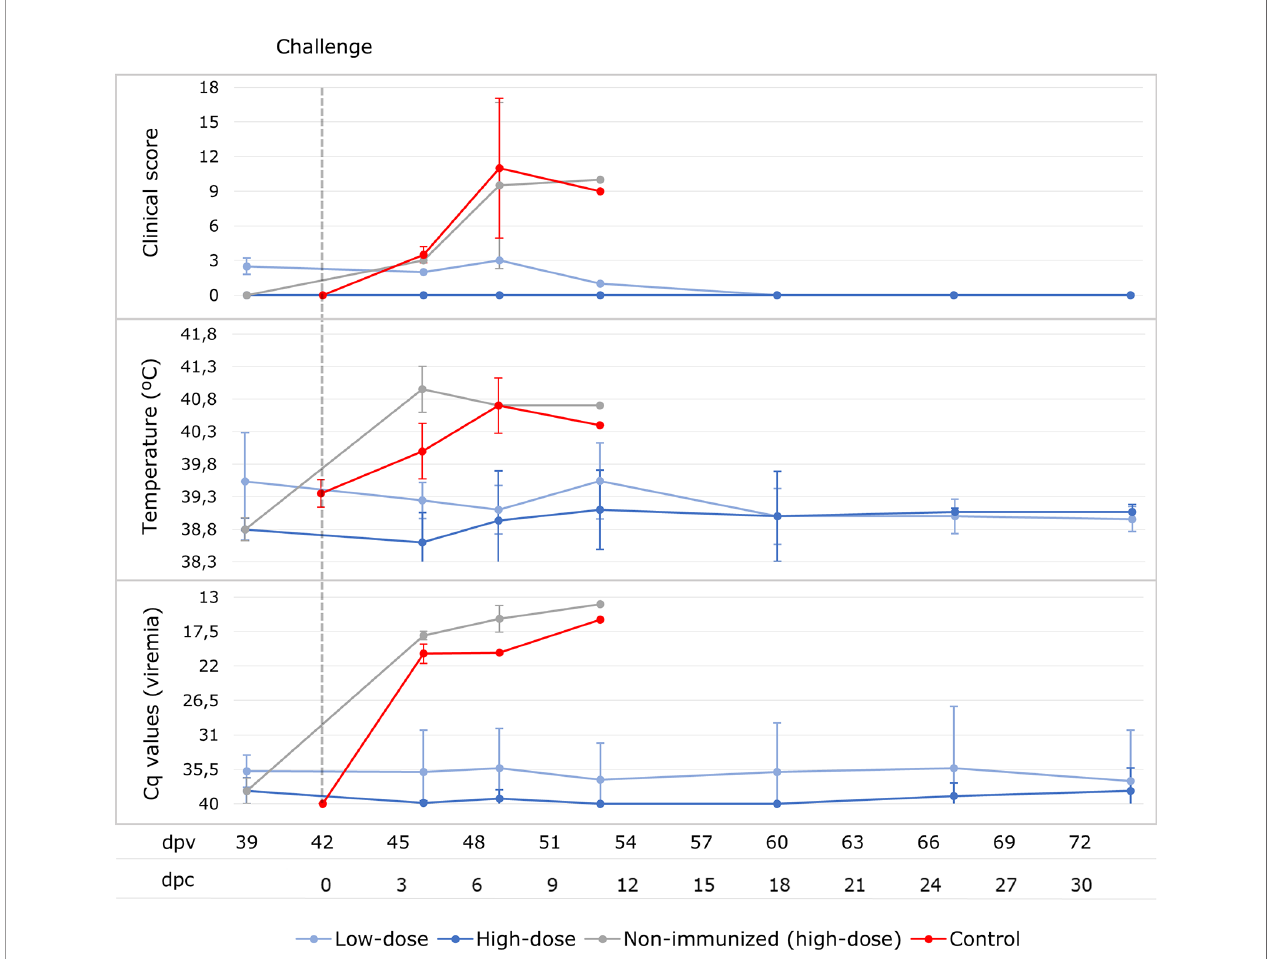
FIGURE 4 | Averages of clinical score, rectal temperature and viremia expressed in Cq values of real-time PCR carried out for wild boar orally vaccinated with 10 3 TCID 50 (low-dose group; light blue) and 10 4 TCID 50 of Lv17/WB/Rie1 ASFV (high-dose group; dark blue) and two naïve wild boar (control; red) after the IM challenge with 10 HAD 50 of Arm07 at 42 days post-vaccination (dpv) at the sampling days post-challenge (dpc). The results obtained for the two non-surviving animals from the high-dose group after the challenge are presented separately (light